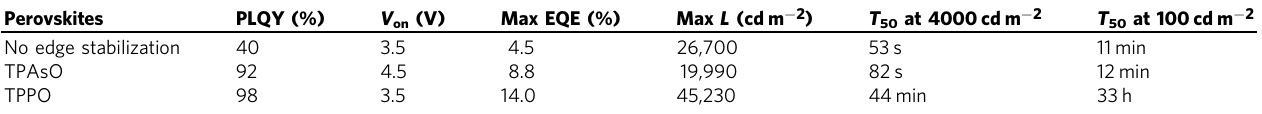
Table 1 Device performance and operational stability of LEDs based on perovskites with and without edge stabilization.